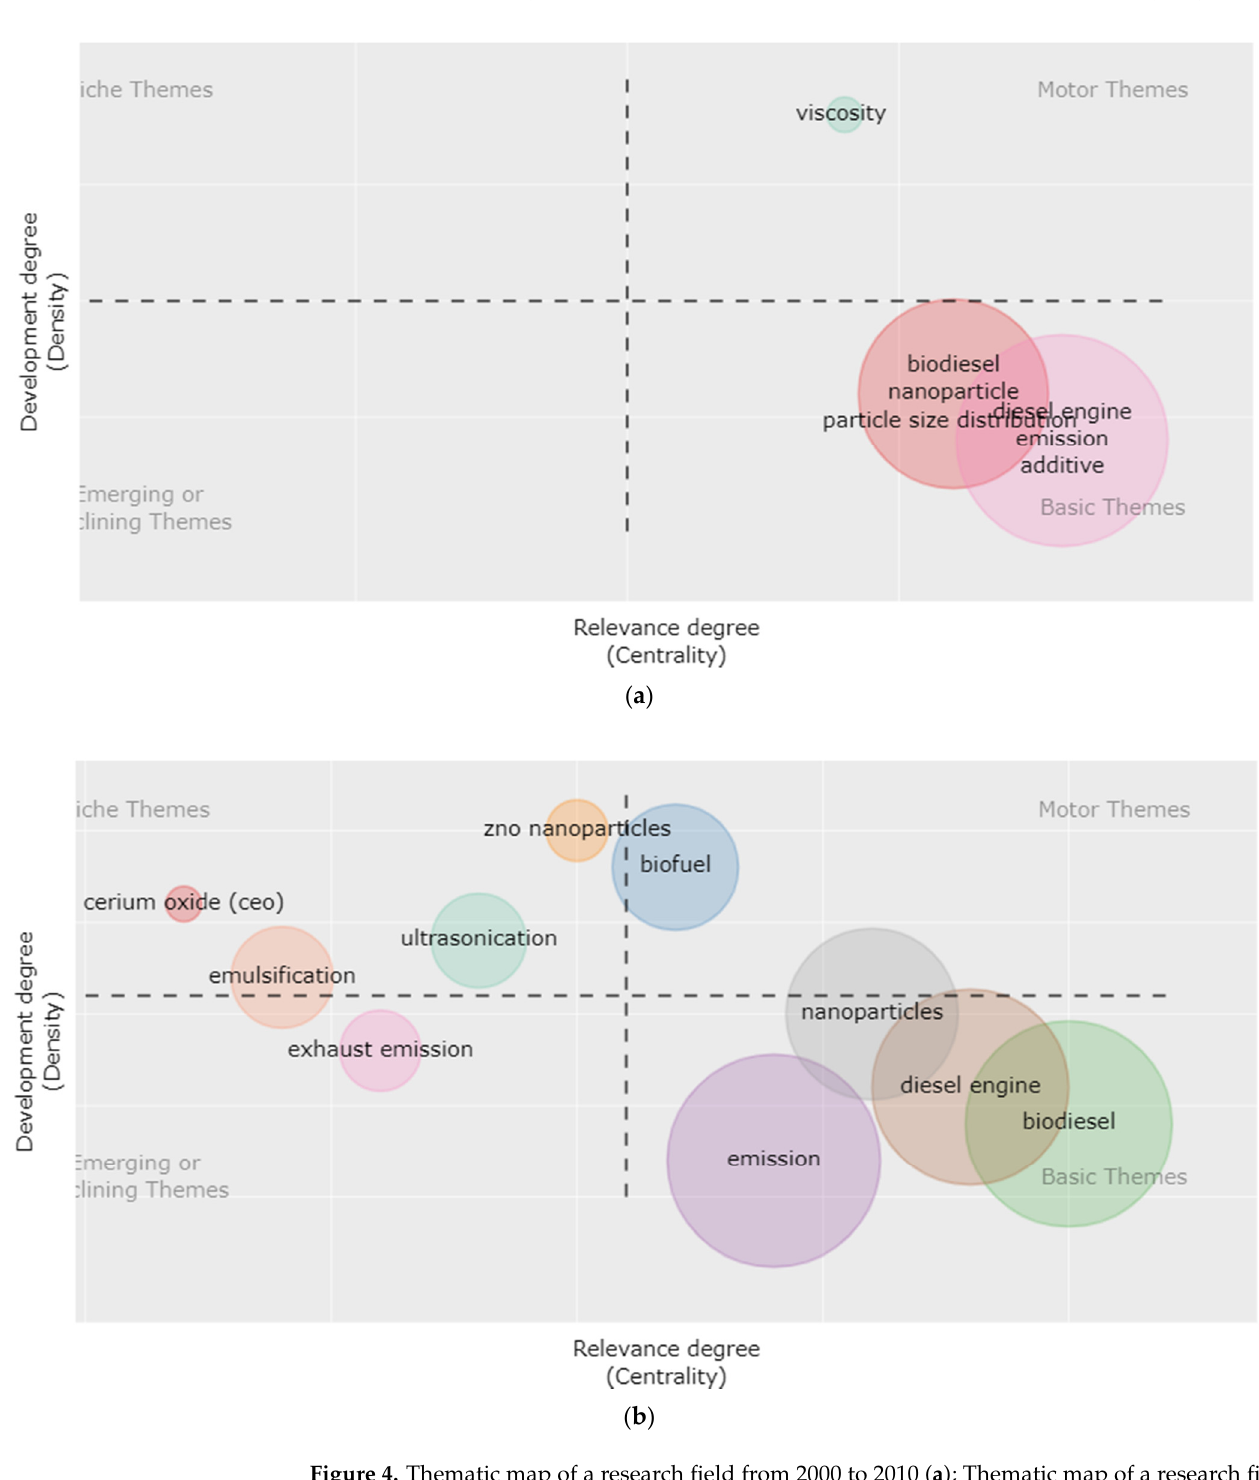
Figure 4. Thematic map of a research field from 2000 to 2010 ( a ); Thematic map of a research field from 2011 to 2021 ( b ).